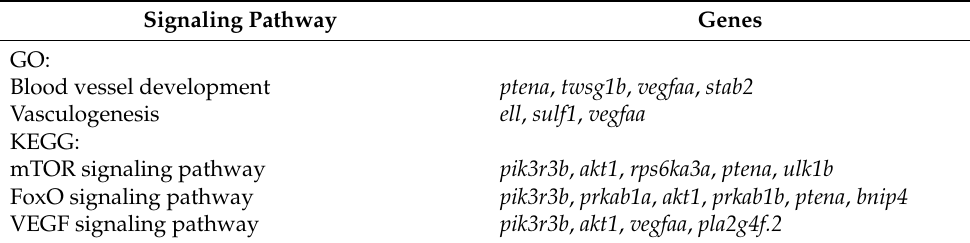
Figure 5. Gene ontology (GO) enrichment and Kyoto Encyclopedia of Genes and Genomes (KEGG) signaling pathway analysis of co-expression down-regulated DEGs. ( A ) GO analysis of co-expression down-regulated genes; bar plot shows the top ten enrichment score ( − log10 ( p -value)) of DEGs involving biological process, cellular component, and molecular function. ( B ) The significant changes in the KEGG pathway of co-expressed down-regulated genes. The bubble graph shows the enrichment score ( − log10 ( p -value)) of the significant pathway. The size of the circle represents the number of enriched DEGs. p -value was represented by a color scale, and the statistical significance increased from blue (relatively lower significance) to red (relatively higher significance). ( C ) Protein–protein interaction network of these fifteen DEGs and wnt16 . Nodes represent genes, lines represent the interaction of proteins with genes, and the results within the nodes represent the structure of proteins. Line color represents evidence of the interaction between the proteins. Table 1. Down-regulated genes gathered in gene ontology (GO) enrichment and Kyoto Encyclopedia of Genes and Genomes (KEGG) signaling pathway related to skeletal